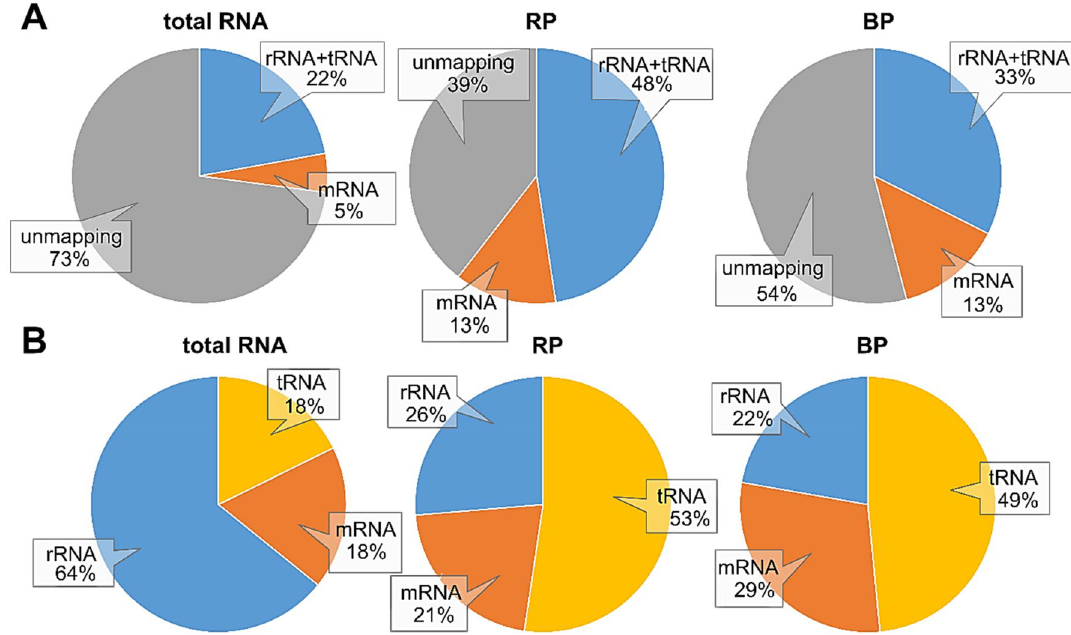
Figure 4. Distribution of reads mapping to the different RNA species or mapping not at all to the genome after RNA-seq. ( A ) Distribution of all raw reads, including those not mapping. ( B ) Distribution of the fractions of reads that map to the reference genome. Total RNA, untreated control sample; RP, sample treated with riboPOOLs; BP, sample treated with the biotinylated